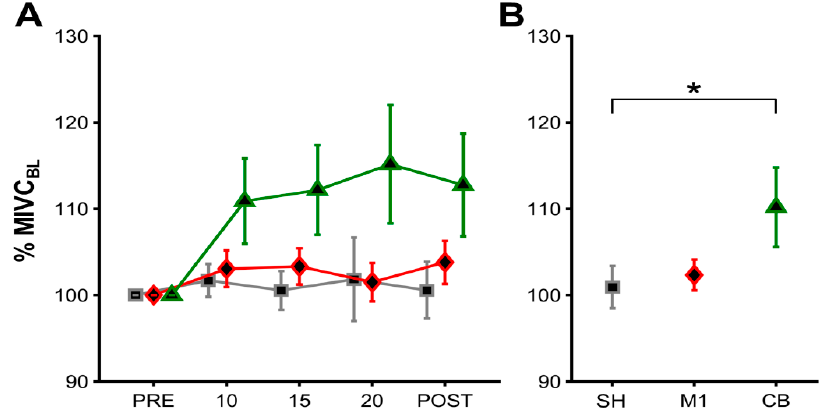
Figure 5. MIVC results II. Mean MIVC and standard error of the mean (SEM) values illustrated as percentage-wise increase respective to baseline MIVC values (% MIVC BL ), per SH-TDCS (grey squares), M1-tDCS (red diamonds), and CB-tDCS (green triangles) for all participants. ( A ) Depicts mean MIVC results averaged across participants, while ( B ) illustrates mean MIVC results averaged across participants and time to highlight general tDCS effects. Asterisks indicate significant differences between tDCS stimulations. Respective p values are reported in the Results section.